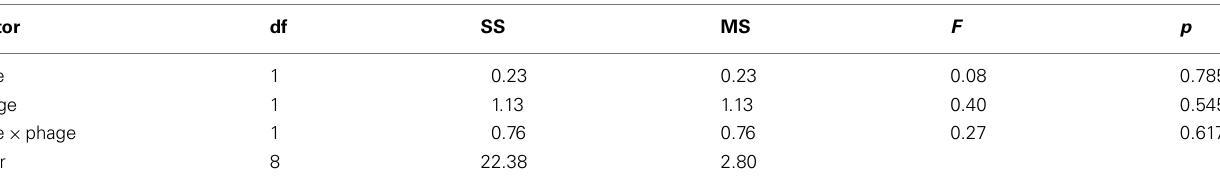
Table 5 |ANOVA results on the total number of morphotypes from both the competitor genotype and the focal genotype (time-averaged for days